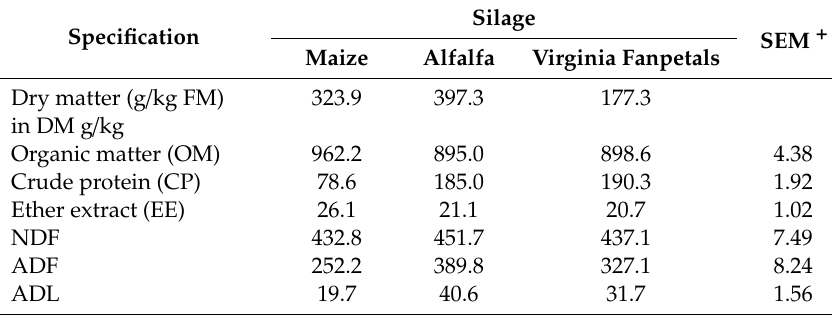
Table 2. Chemical composition of silages (g / kg